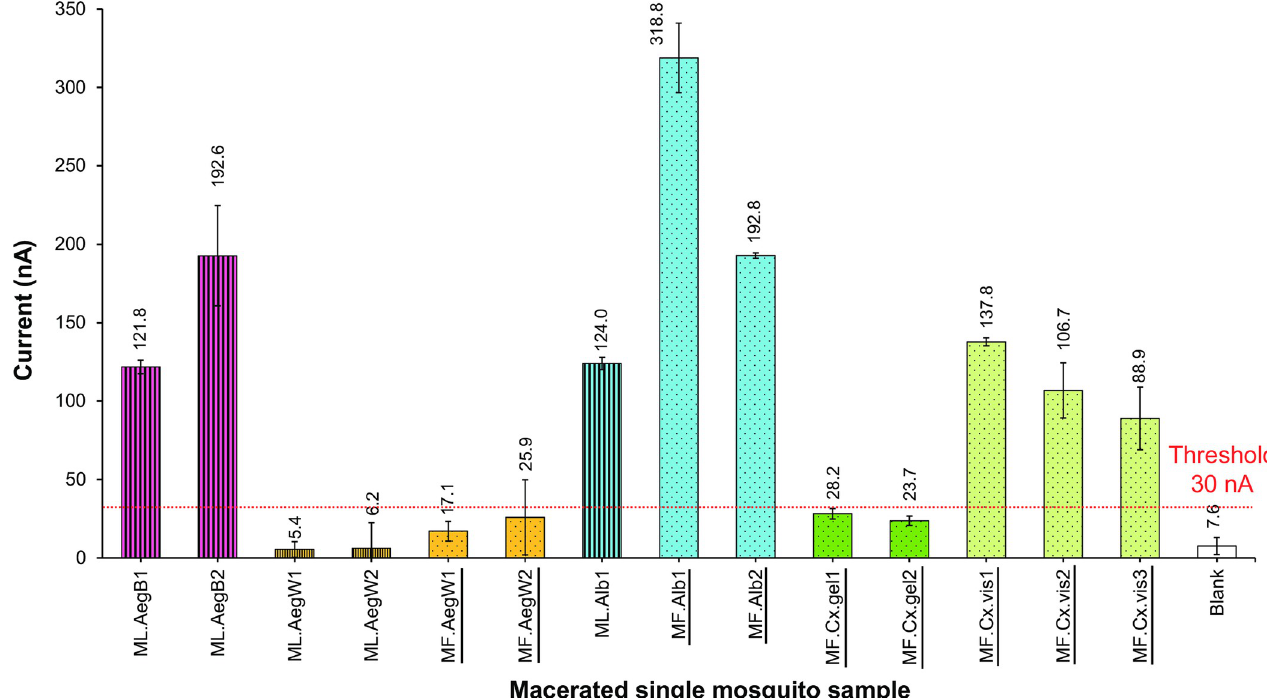
Fig 6. Electrochemical detection of macerated mosquitoes of laboratory colonies (ML) and field samples (MF). Different mosquito species were included as follows: wild-type Aedes aegypti (AegW, if ML: Aae-JJ), w AlbB trans-infected Thai Ae . aegypti (AegB, w AlbB-TH), Aedes albopictus (Alb, if ML: Aal-CH), Culex gelidus (Cx . gel) and Culex vishnui (Cx . vis) . Samples giving peak currents above 30 nA (approximately four-times blank signal) were considered positive. The bar charts represent the mean of 5 replications of DPV measurement and standard deviation was shown. Different patterns indicate either laboratory colony or field samples. Colors indicate different mosquito colonies or